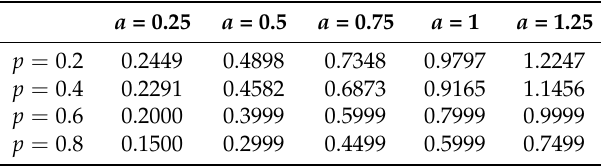
Table 4. The least upper bound of b for Example